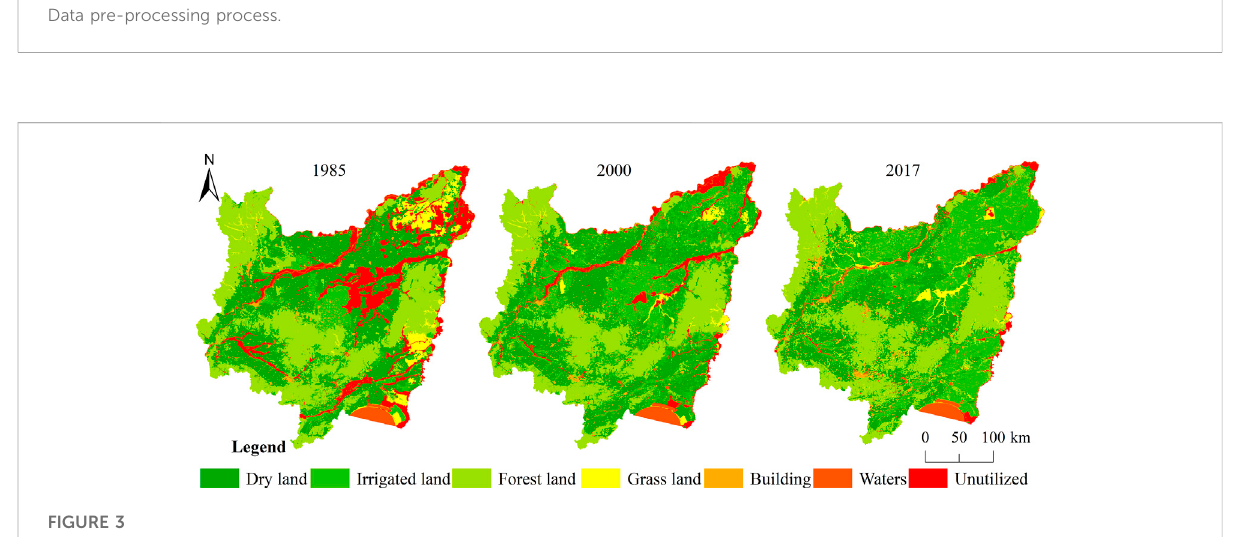
FIGURE 3 1985 – 2017 Land use/Land